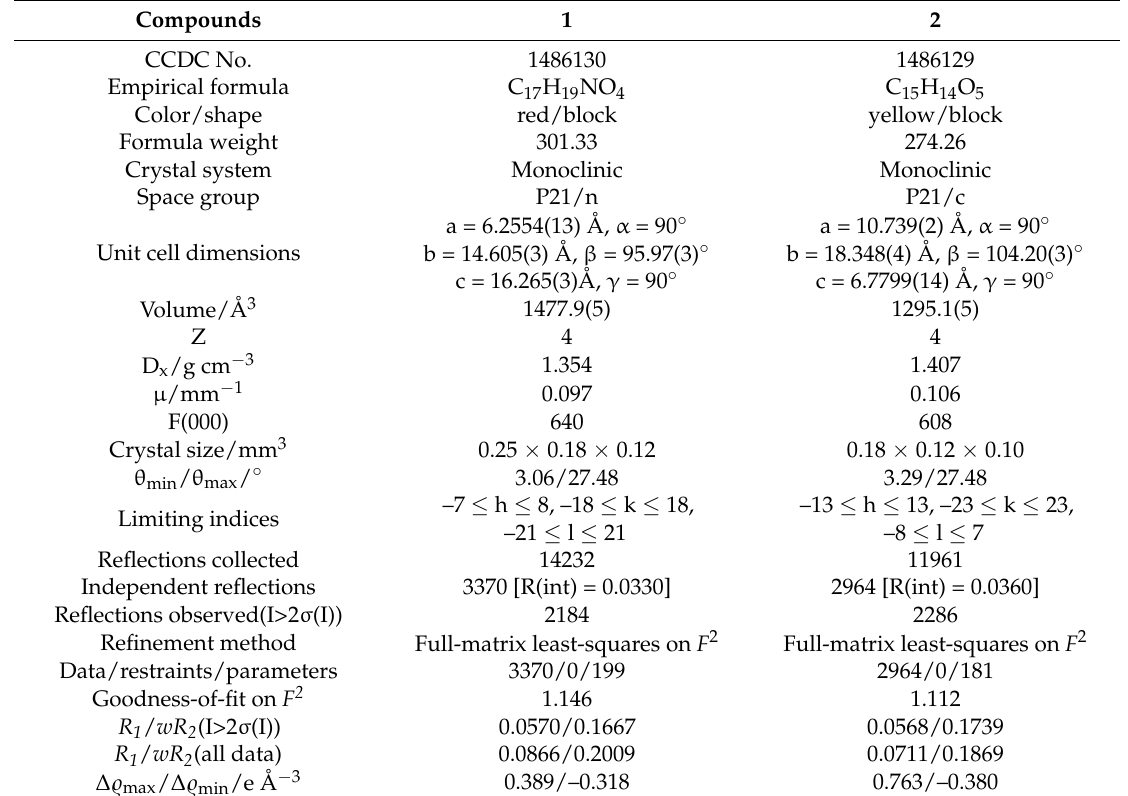
Table 4. Crystal and experimental data for 1 and 2